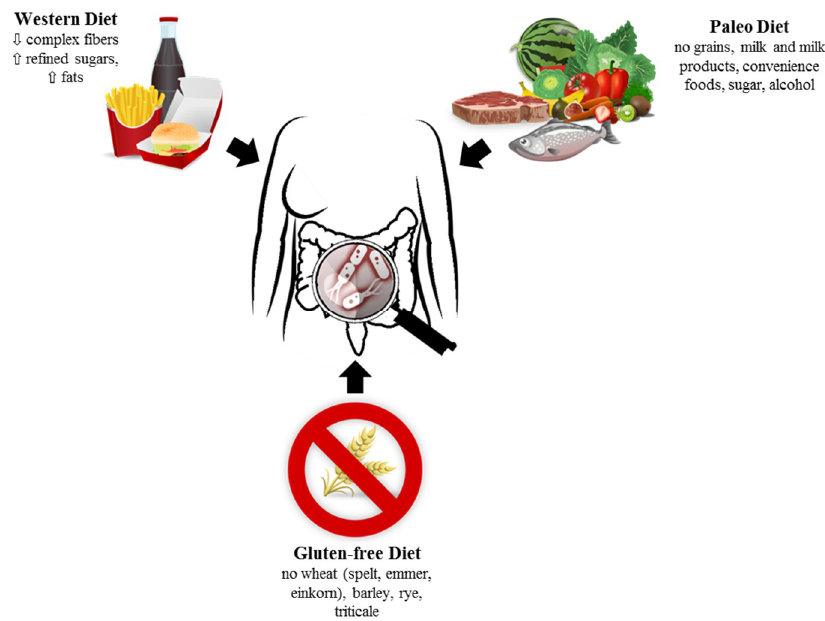
Figure 1. Diets strongly influence gut microbiota. Further studies must evaluate the impact of diets on gut health.